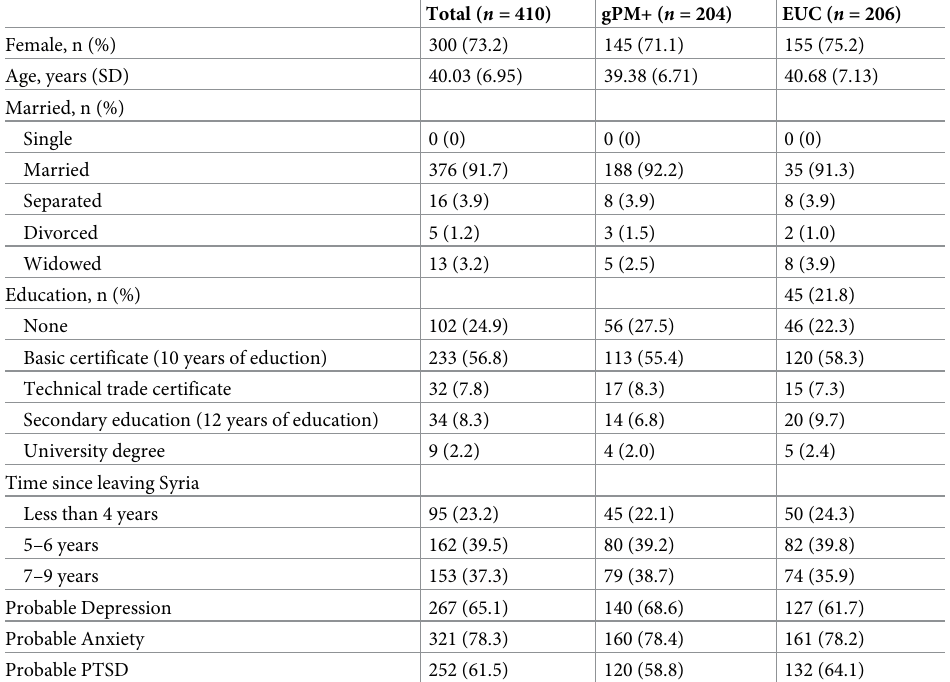
Table 1. Participant